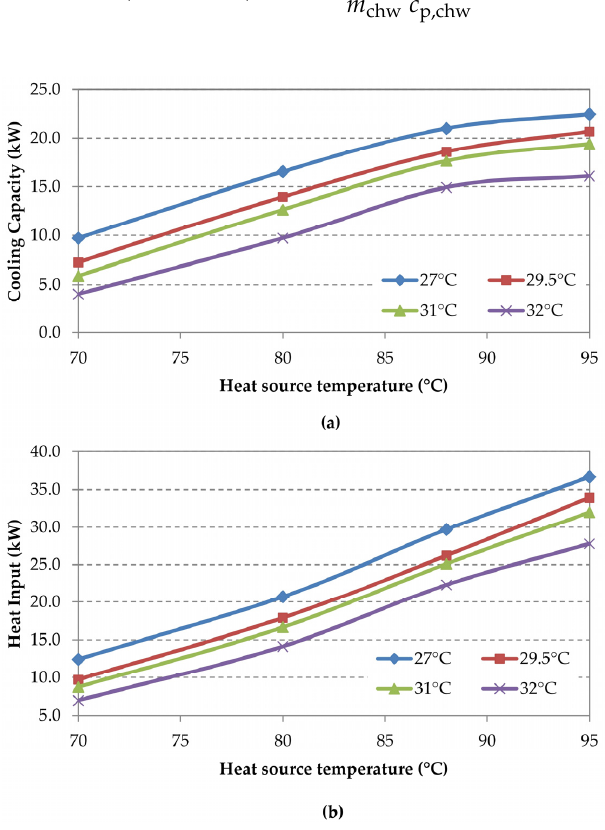
Figure 8. Cooling capacity ( a ) and heat input ( b ) of the considered AHP as a function of the heat source and cooling water temperature.